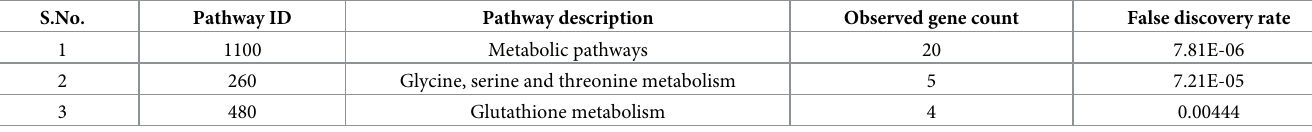
Table 8. The significantly enriched KEGG pathways of the RA synovial mitochondrial DEGs. S.No.